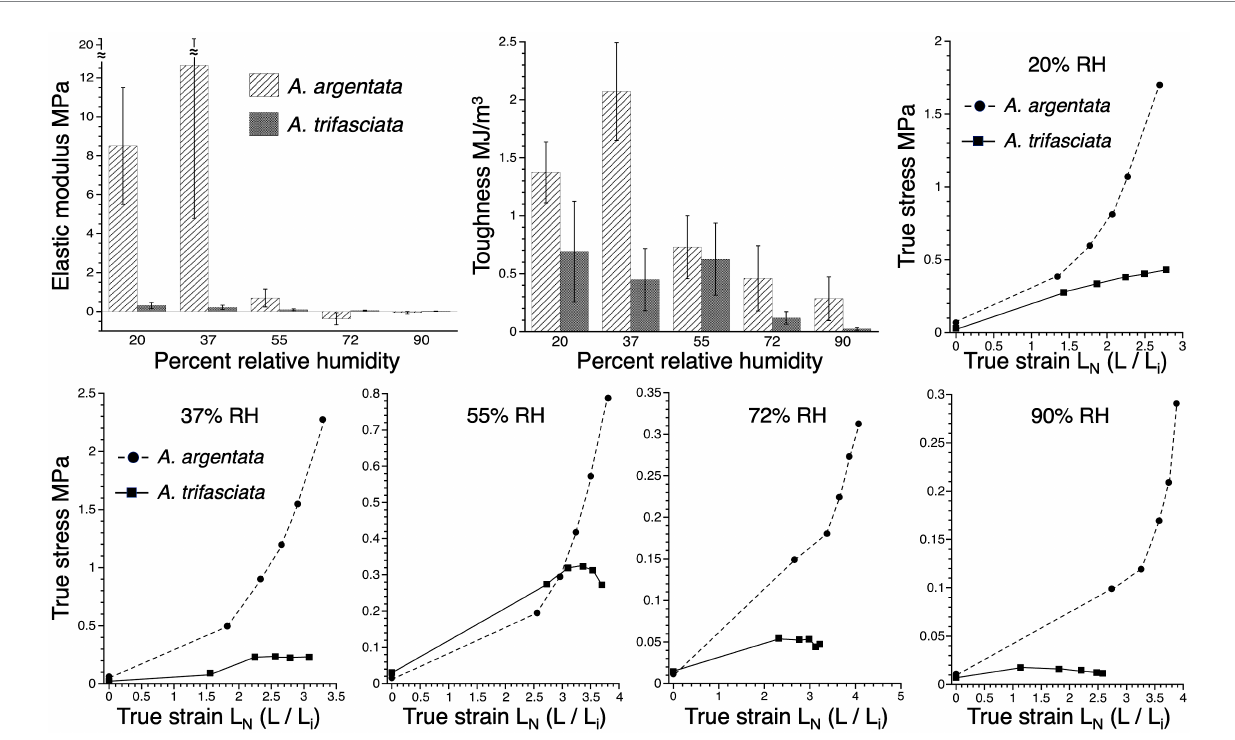
FIGURE 3 Material properties of A. argentata and A. trifasciata protein cores: elastic modulus and toughness at five humidities and the humidity-specific true stress—true strain curves from these species, based on mean stress and strain values. Material property values are mean ± standard